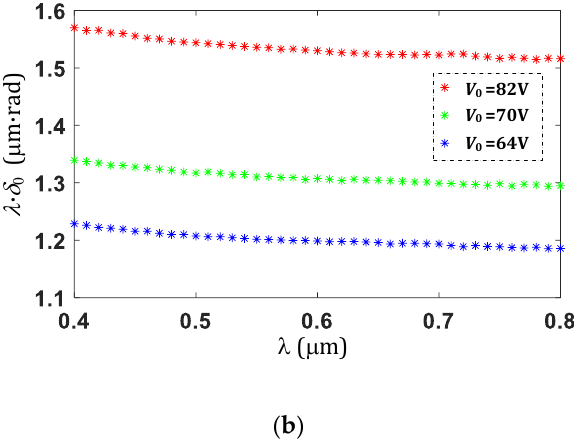
Figure 4. ( a ) Amplitude of the PEM retardation